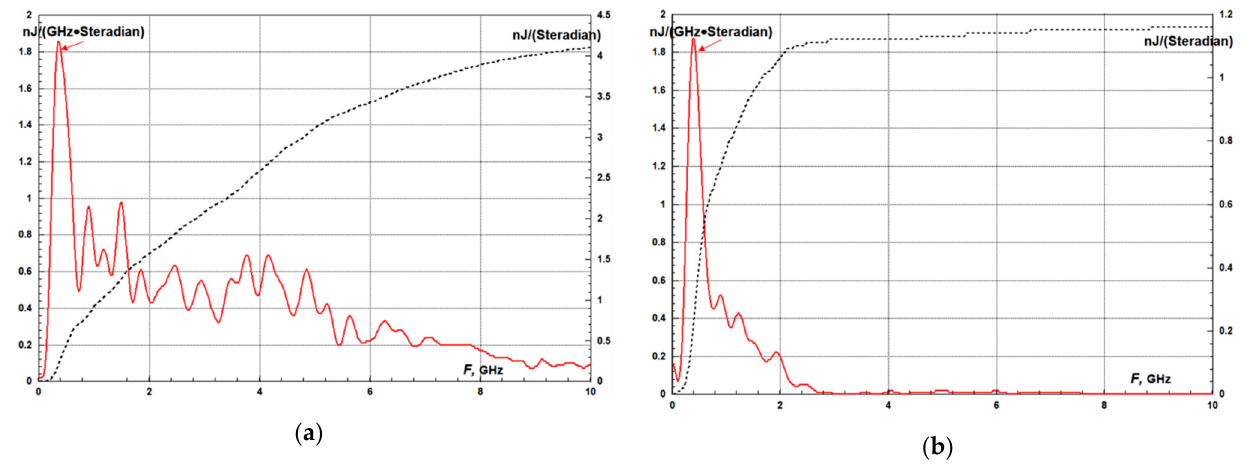
Figure 10. Energy spectrum density for the radiation potential E ( t ) R from antenna A16 excited by the TMG40R generator. ( a ) The data from Figure 9a at a time window ∆ t = 0.5 ns. ( b ) The data from Figure 9b.